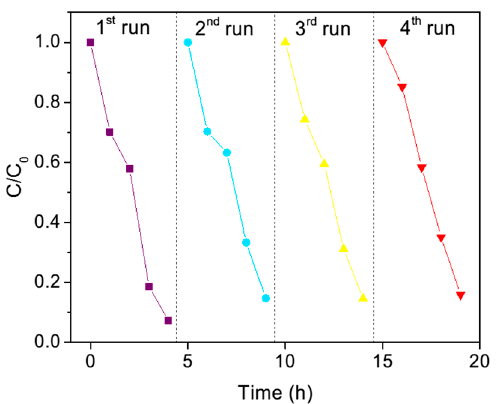
Figure 15. Recyclability of methylene blue dye degradation rate for BiVO 4 microspheres calcined at 400 °C for four cycles.